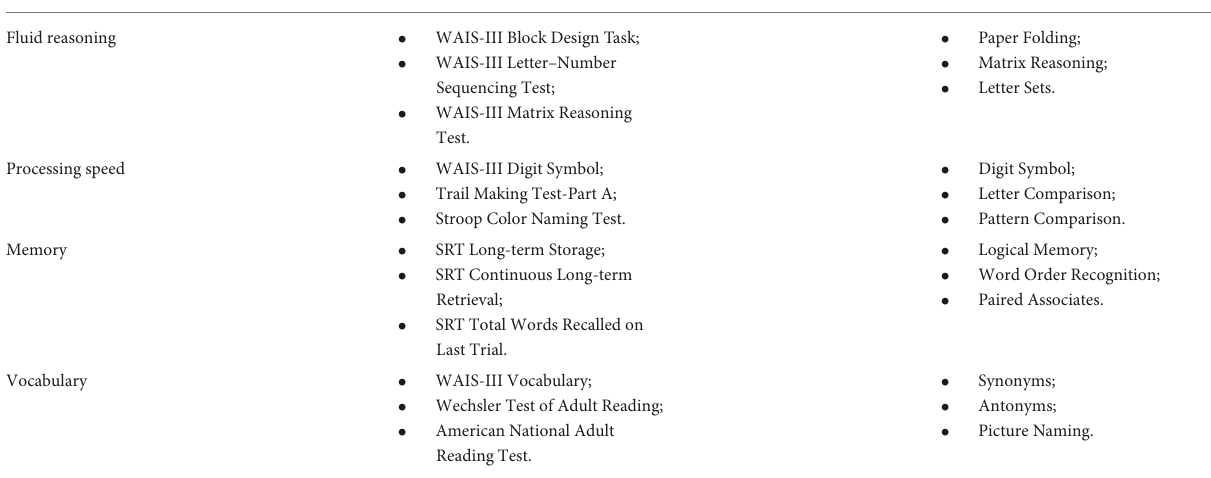
TABLE 1 Measurements of reference